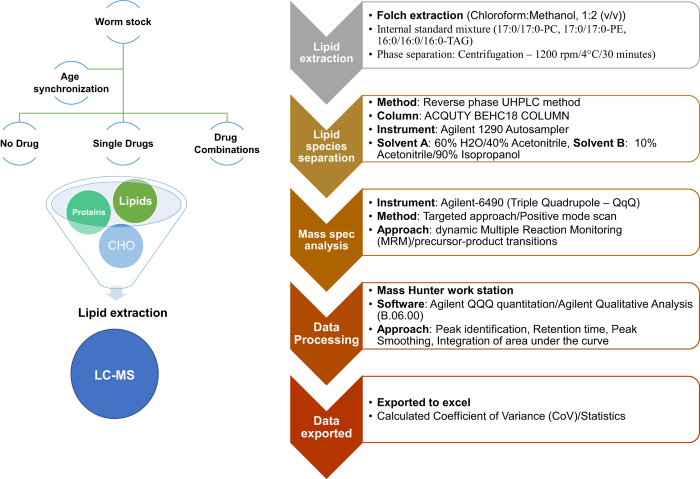
Overview flowchart of sample preparation, extraction, data generation and analysis.Age synchronized young adult nematodes were treated with individual drugs, drug combinations or vehicle for two days, starting at day four of age, followed by harvesting and lipid extraction at day six. Lipid species were separated by reverse phase UPLC and subjected to MS analysis. Data were processed using the Mass Hunter Workstation software package (Agilent, version B.06.00) and exported to excel for statistical analysis.